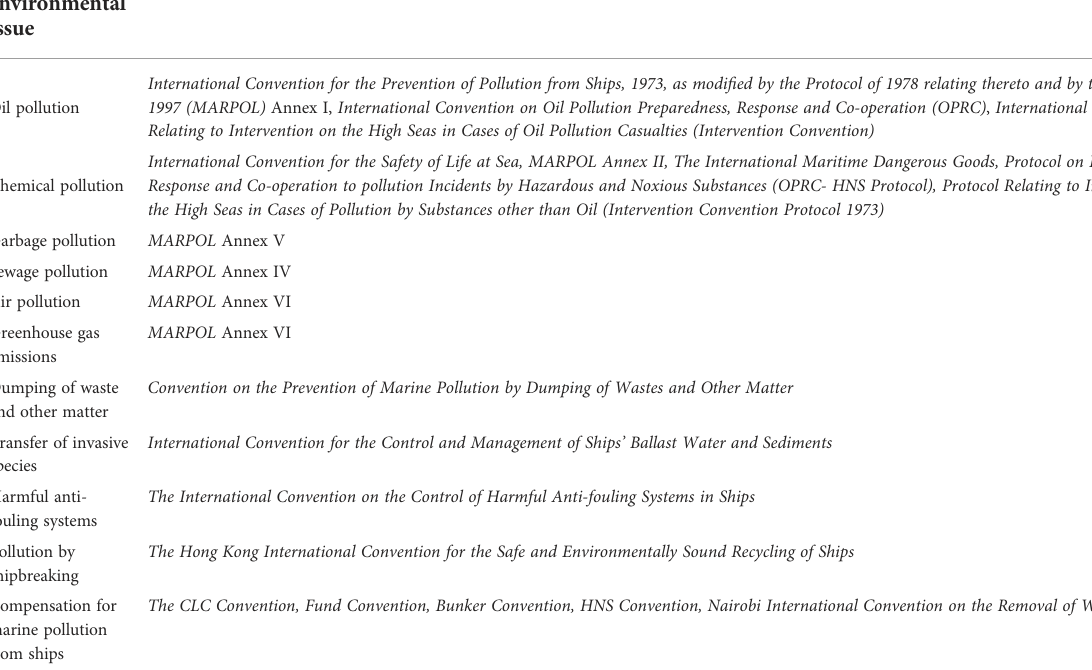
TABLE 1 International instruments concerning marine environment